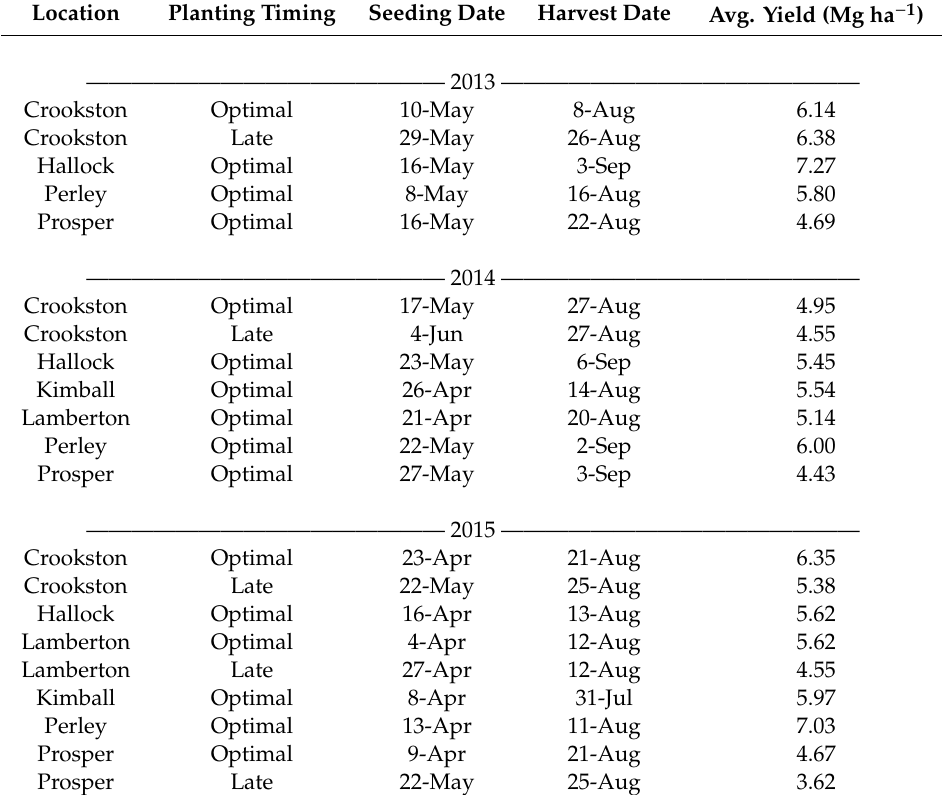
Table 3. Site location and year characteristics for hard red spring wheat (HRSW) trials conducted in Minnesota and North Dakota,